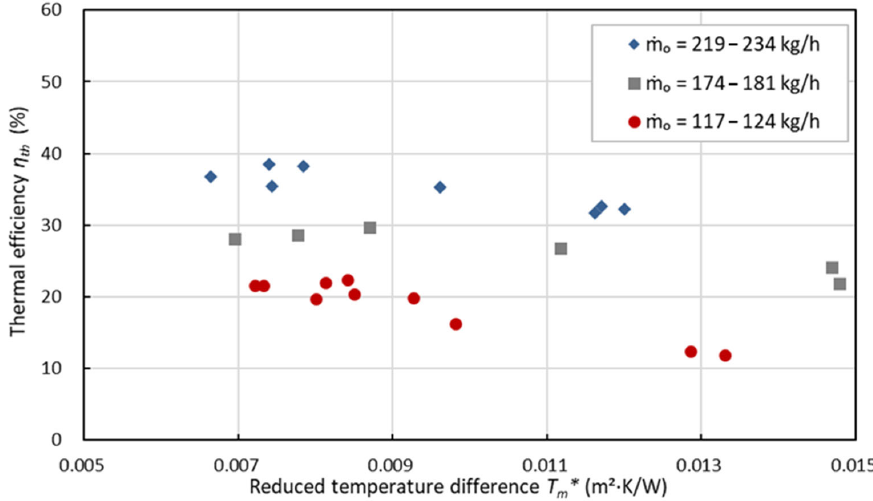
Figure 16. Thermal efficiency at different reduced temperatures and flow rates.